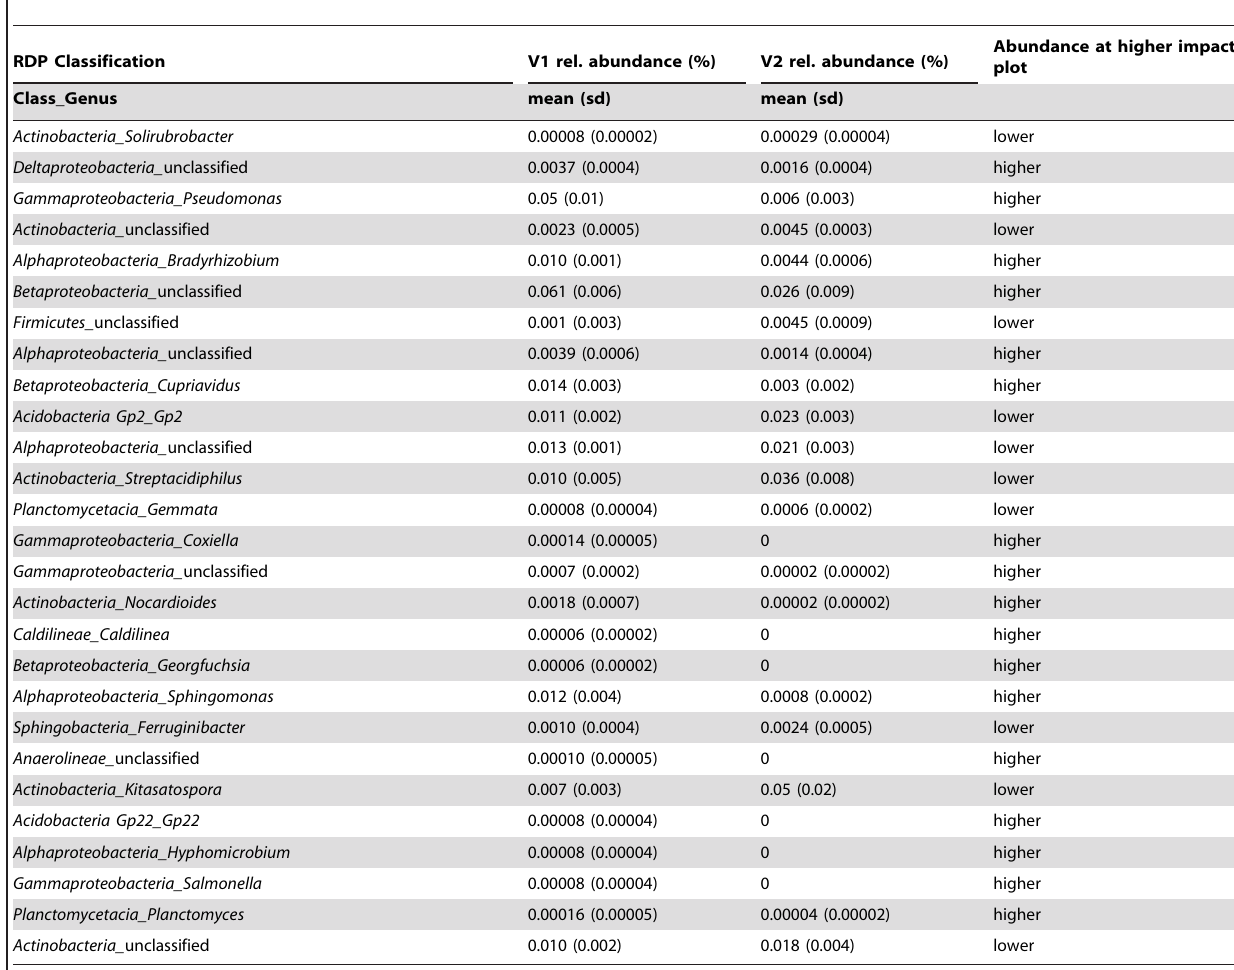
Table 5. Bacterial phylotypes at the Genus level with differing abundance between Vohibe high impact (V1) and low impact (V2) sites (Metastats p ,